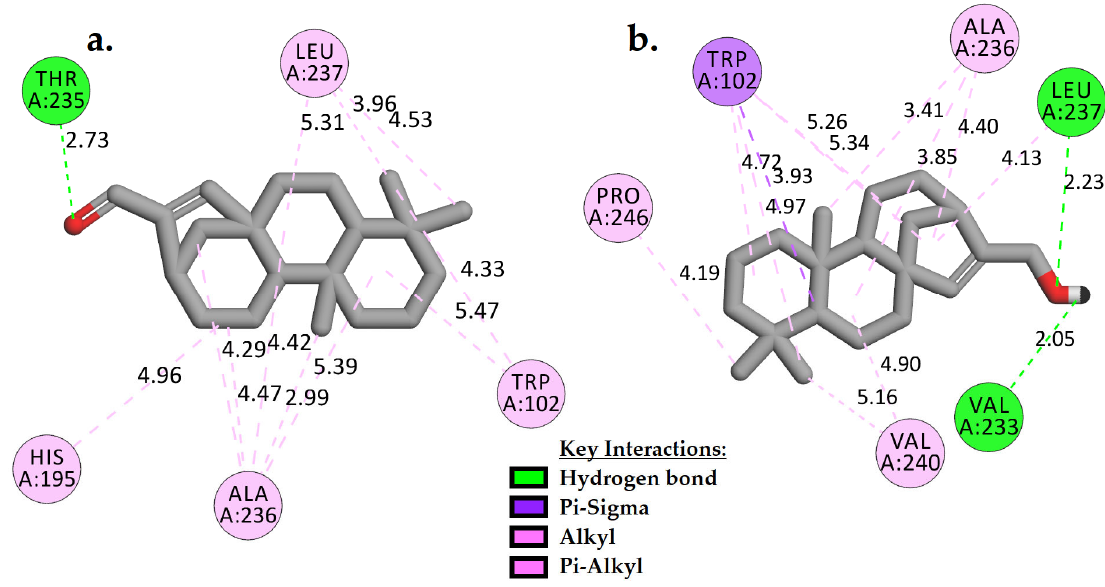
Figure 2. Two ‐ dimensional interaction analysis of docked models of compounds 1 ( a ) and 2 ( b ) with Pf LDH binding